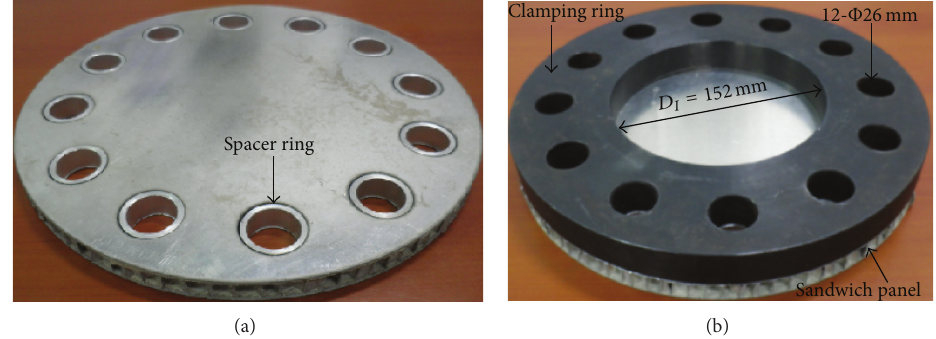
Figure 2: A specimen panel and a panel with a clamping ring. (a) Solid-ring spacers were employed to prevent core crushing while fastening the clamping ring. (b) A steel ring was employed to clamp the sandwich panel to the anvil tube with 12 screws.